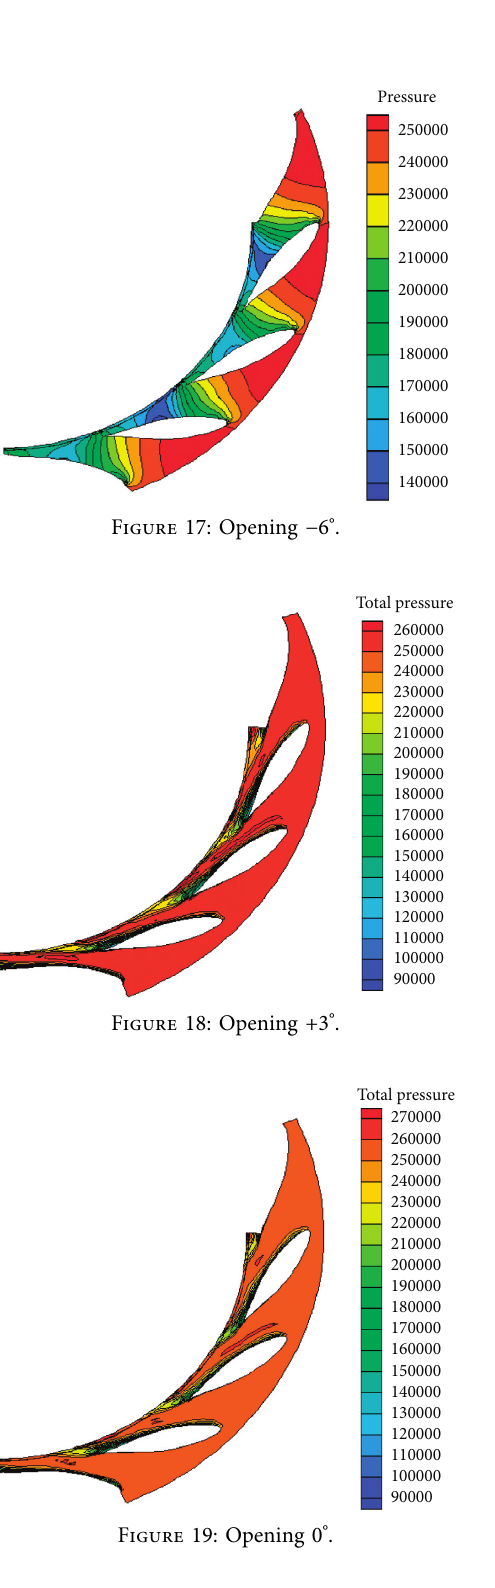
Figure 22: Opening +3 ° .